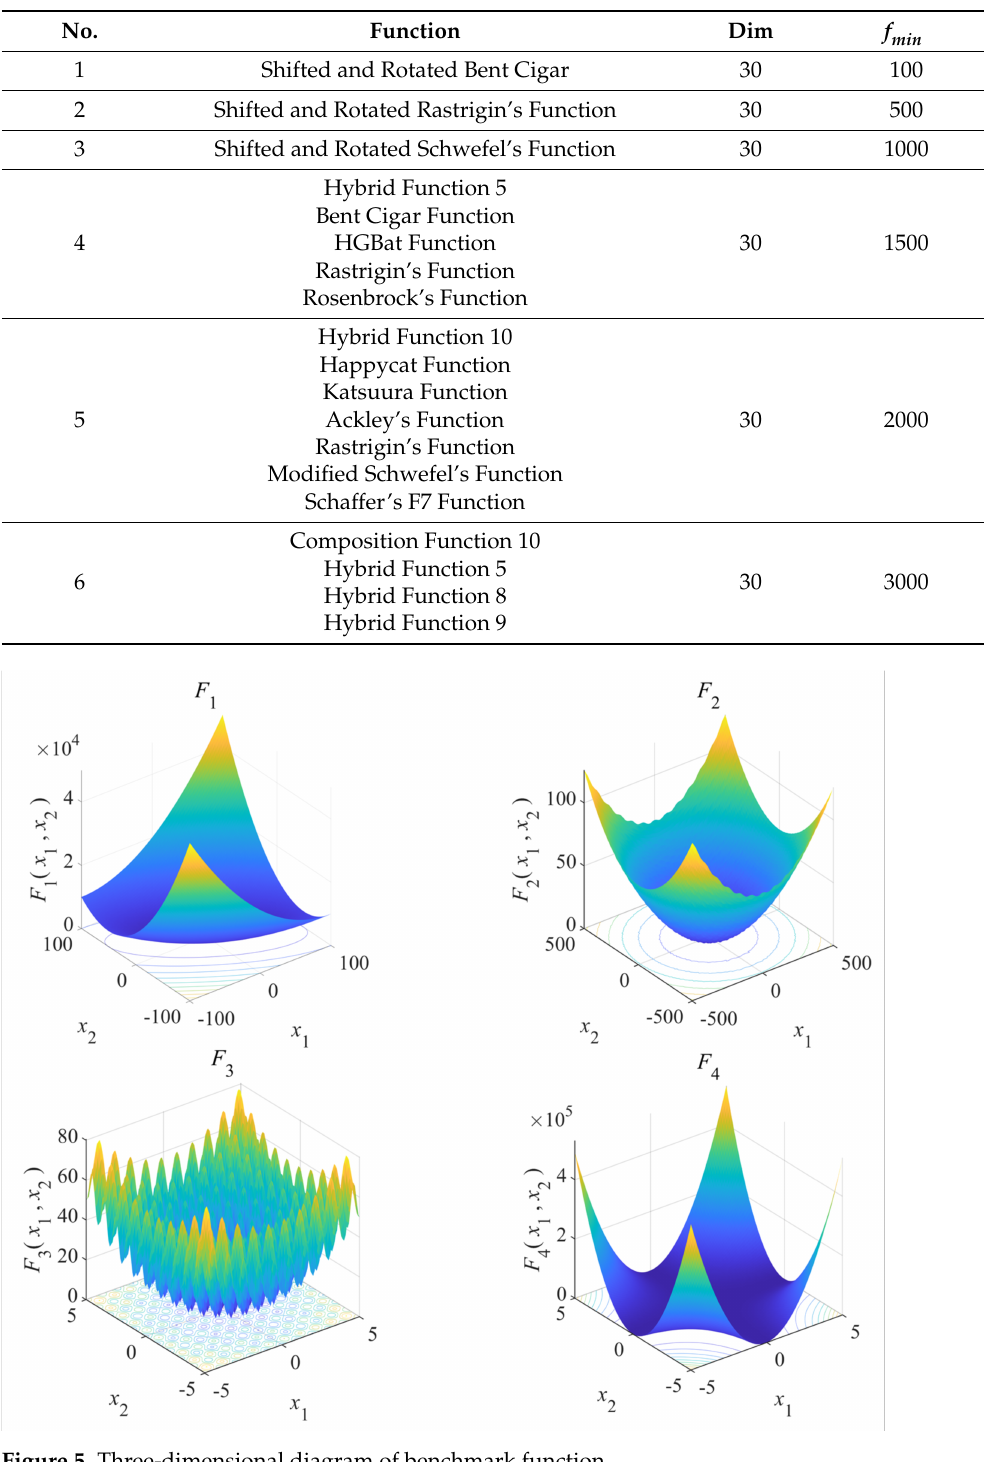
Table 2. CEC-2017 Function.